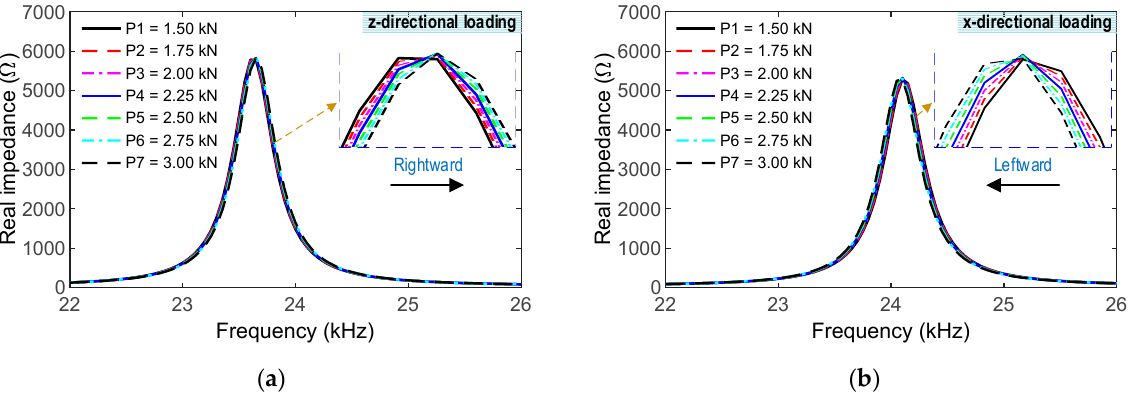
Figure 8. CSA’s impedance signals in frequency range of 10–40 kHz for intact case. ( a ) z-directional loading. ( b ) x-directional loading.